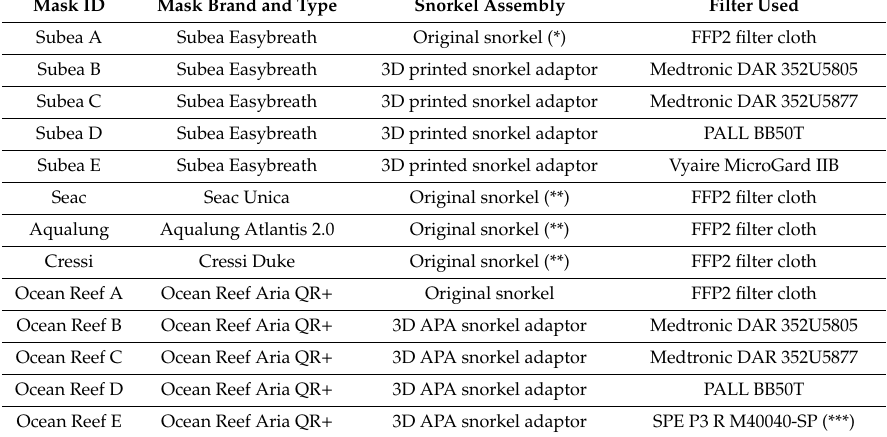
Figure 2. Snorkel mask ‘makeshift’ configuration with FFP2 cloth (photos courtesy M. Gillis). Table 1. Snorkel mask configurations